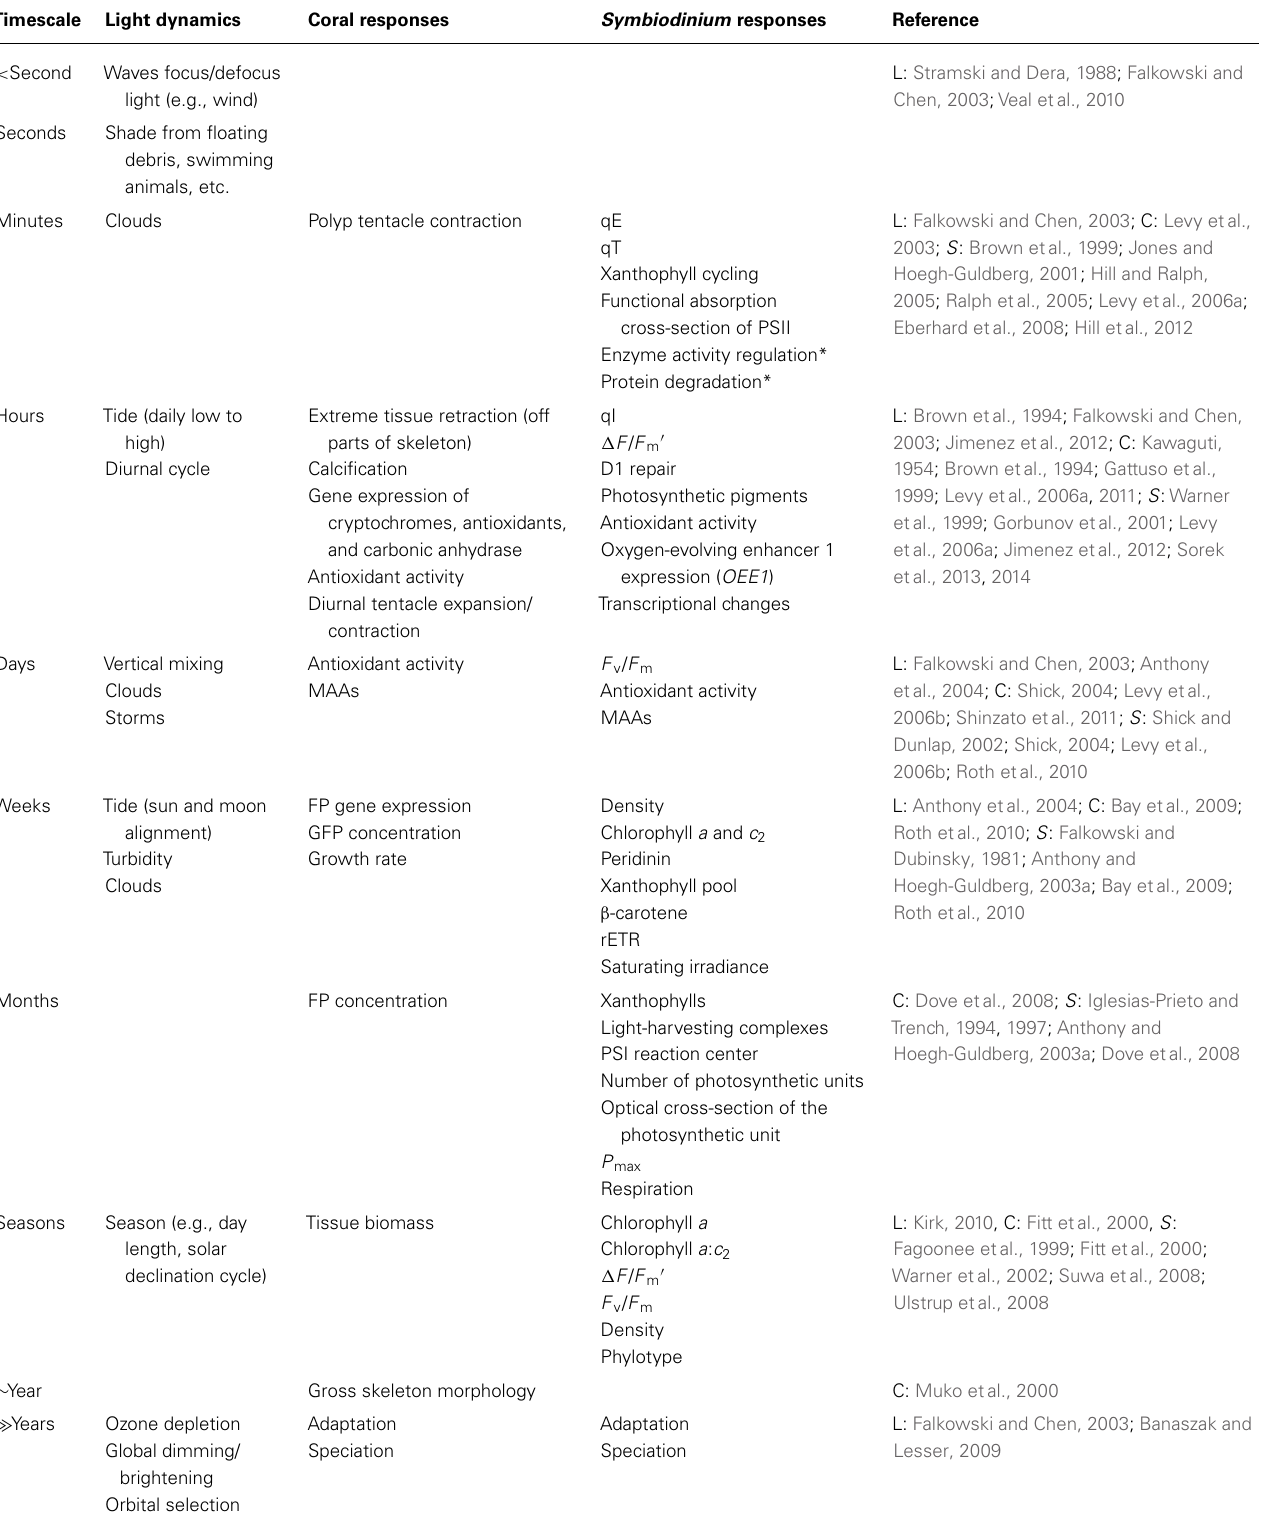
Table 1 |Timescales of light dynamics and responses by the coral–algal symbiosis. Timescale Light